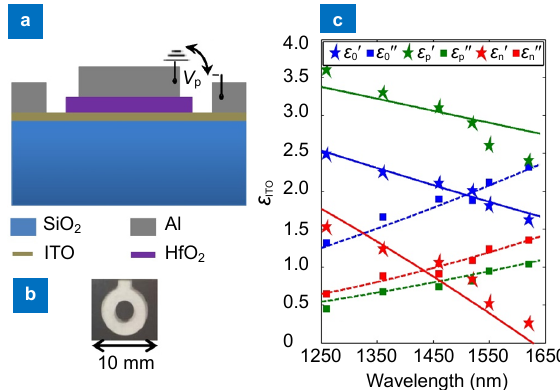
Fig. 4 | The tunability of ITO in a multilayer modulator. ( a ) Cross section of the multilayer ITO modulator. ( b ) Picture of the fabricated modulator. ( c ) Solid and dashed lines are from further fitting by the Drude model. Figure reproduced from ref. 120 , Optical Society of America.